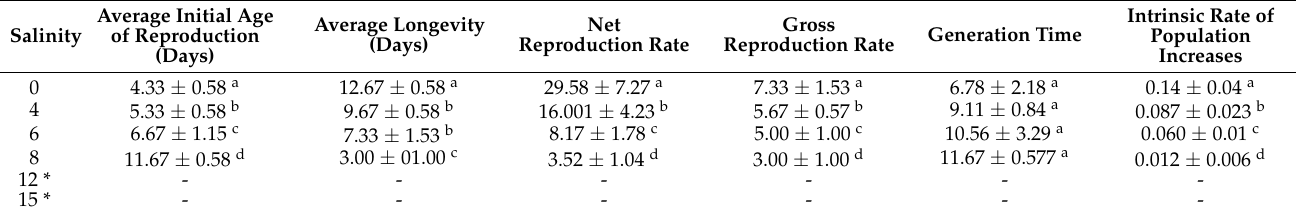
Table 4. Life table parameters for M. macrocopa . All values are mean ± standard deviation ( n = 3). The different small letters indicate significant differences between different salinity ( p < 0.05).